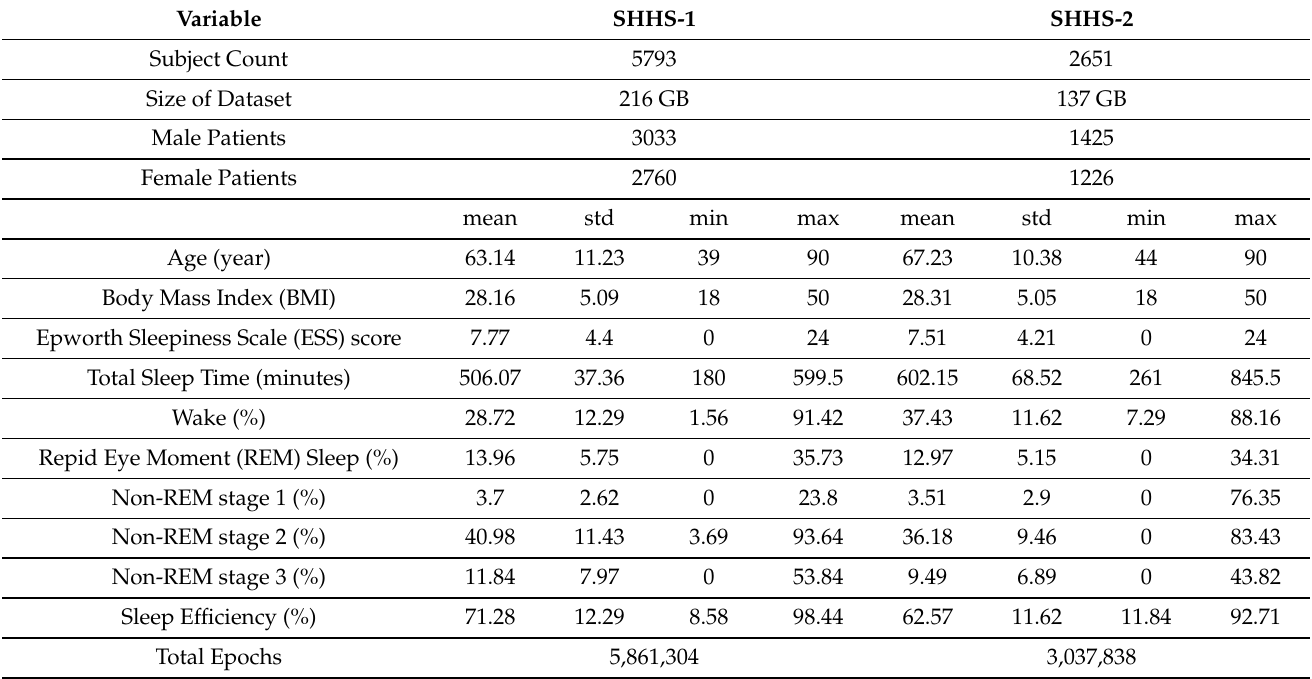
Table 1. Summary of the SHHS